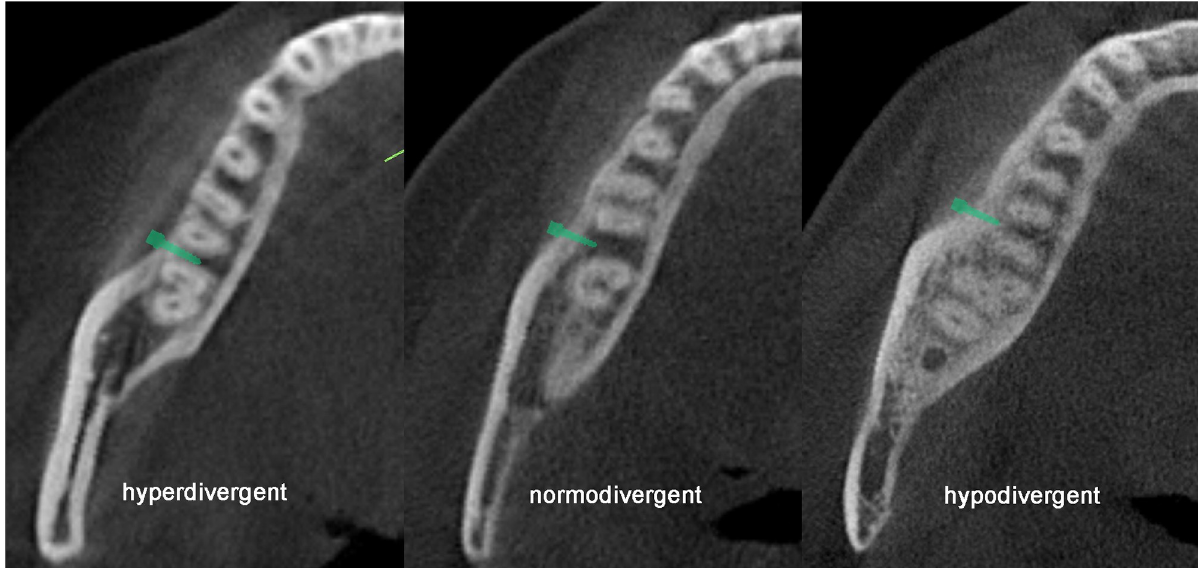
Fig 7. Miniscrew–root distances in the three vertical facial types. Different relationships between roots and miniscrews in the three vertical facial types in the axial slice, demonstrating examples of hyperdivergent, normodivergent, and hypodivergent facial types.